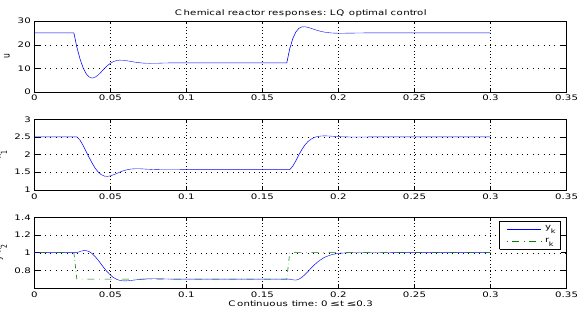
Figure 4: Simulation of the chemical reactor in Exam- ple 6.3 with LQ-optimal